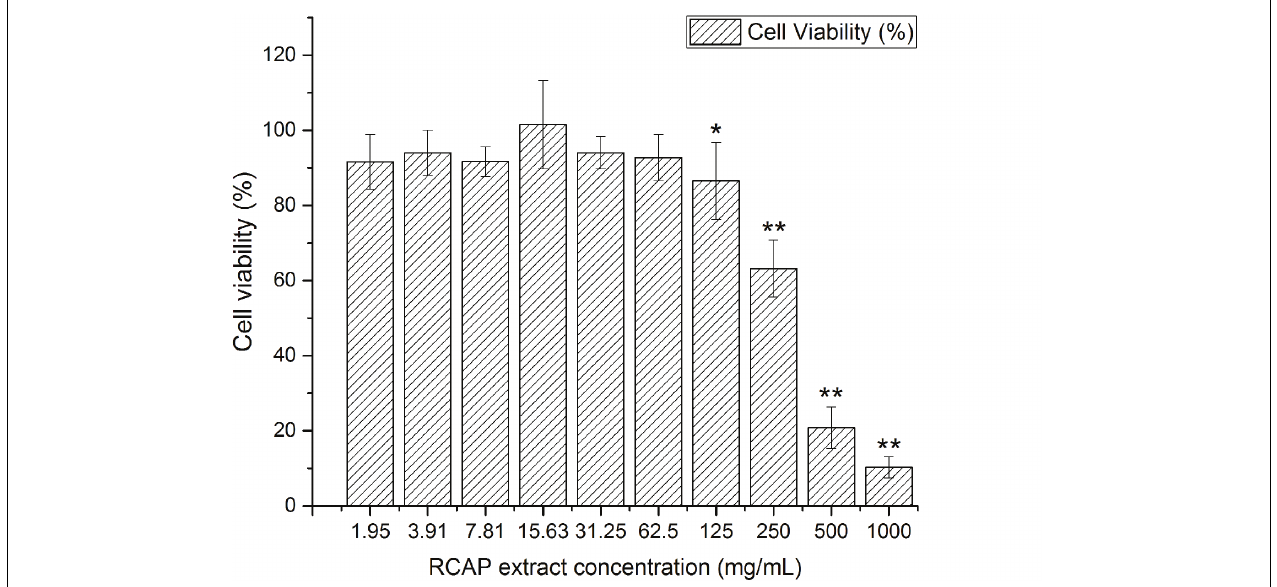
FIGURE 1 | Cytotoxicity of RCAP extract in MA-104 cells. The non-toxic groups were determined by comparing the cell viability. Cell viability was calculated as OD ex / OD con × 100%, and OD con = 1.74 ± 0.06. Data are represented as mean ± S.D. n = 11. ∗ p < 0.05 vs mock; ∗∗ p < 0.01 vs mock by one-way ANOVA test, post hoc Tukey test.